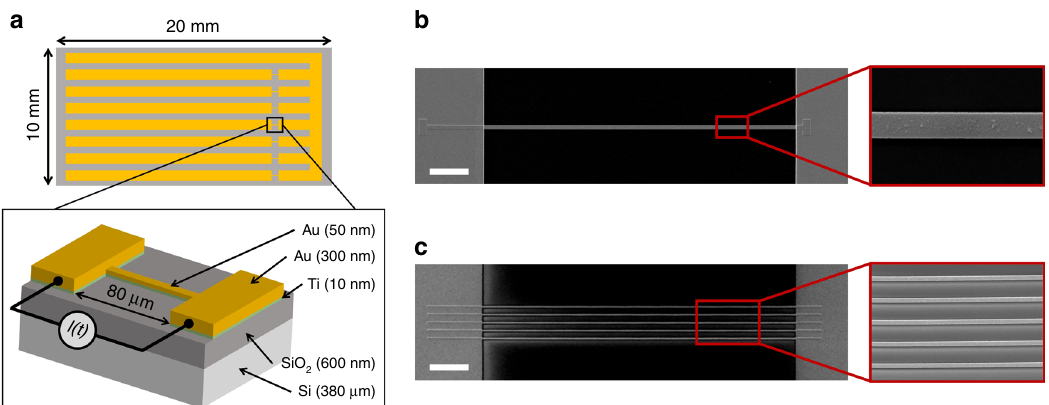
Fig. 2 Description of the Joule-heated gold nanowires used for nanothermometry. a Sketch of the chips used (each comprising seven 80- µ m-long, 50-nm-thick gold wires), and schematic representation of a nanowire on top of an oxidized silicon substrate. Scanning electron microscopy (SEM) images of b a 1- µ m-wide wire and c fi ve parallel 500-nm-wide wires spaced 1.5 µ m apart. Scale bars, 10 µ m.